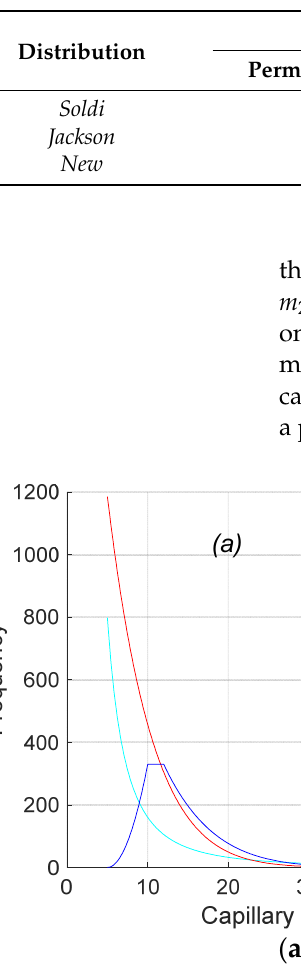
Figure 4. Comparison of Soldi, Jackson and New distribution functions using alternating capillaries with tortuosity of 4.5, 𝑑𝑟 = 0.1 μm , 𝑟 = 5 μm and ( a ) 𝑟 = 60 μm and ( b ) 𝑟 = 100 μm with radial and length factors of 0.7 and 0.2, respectively.